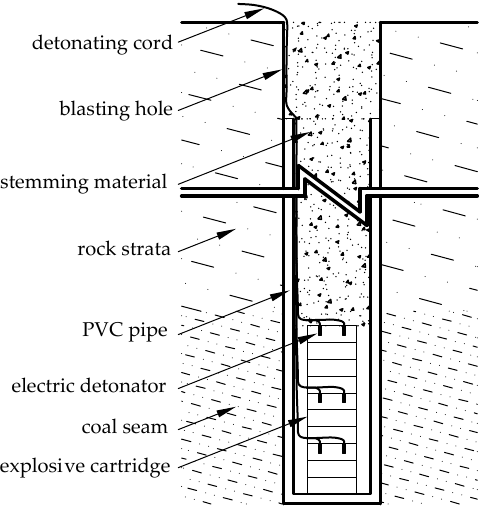
Figure 4. Charge structure in the blasting hole.